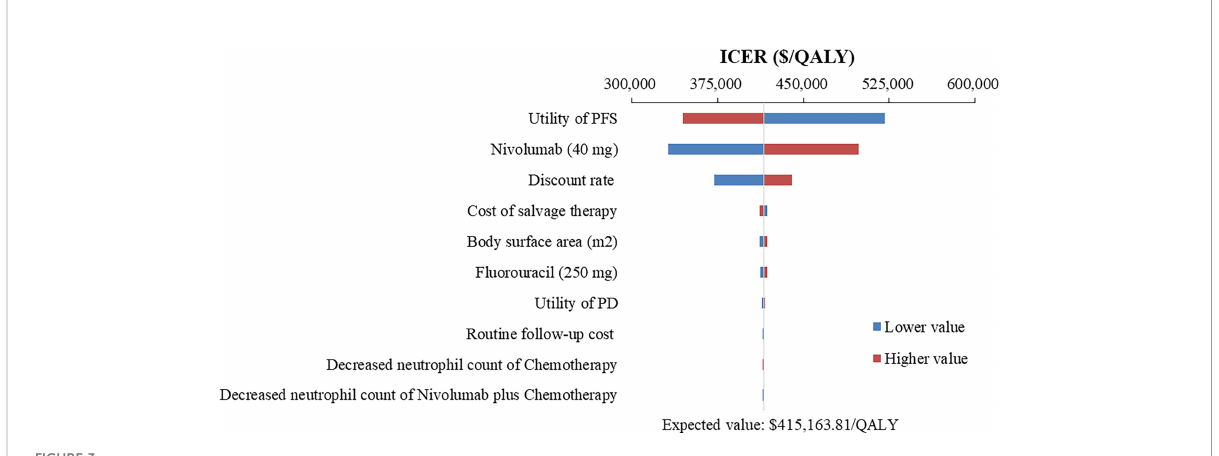
FIGURE 3 Tornado diagram of one-way sensitivity analysis of Nivolumab plus chemotherapy versus Chemotherapy in the treatment of overall advanced ESCC patients. ICER, incremental cost-effectiveness ratio; QALY, quality-adjusted life year; PFS, progression-free survival; PD, progressive disease.